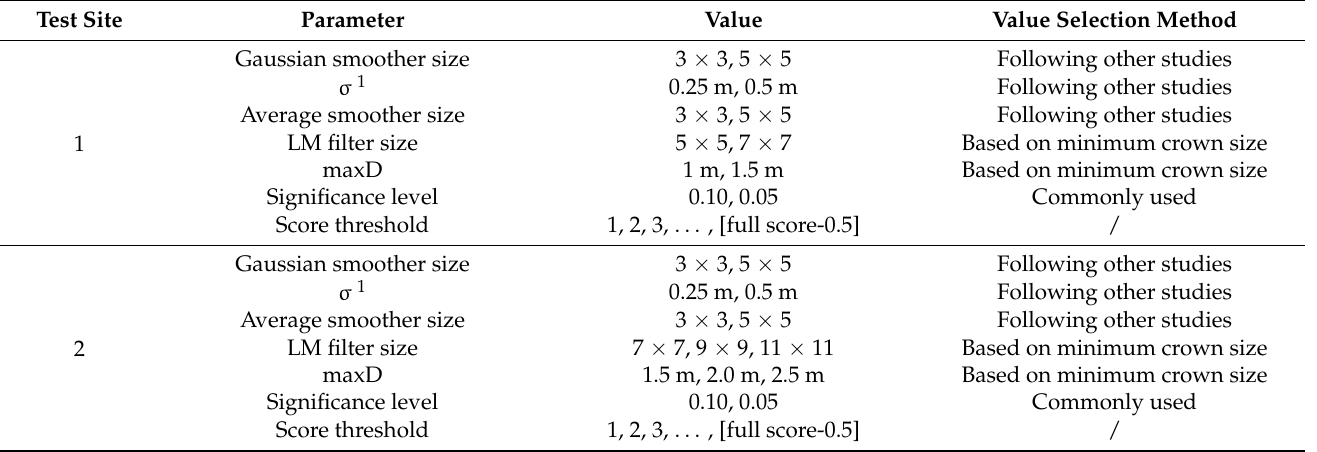
Table 1. List of parameters and their values used in the proposed approach on test sites 1 and 2.